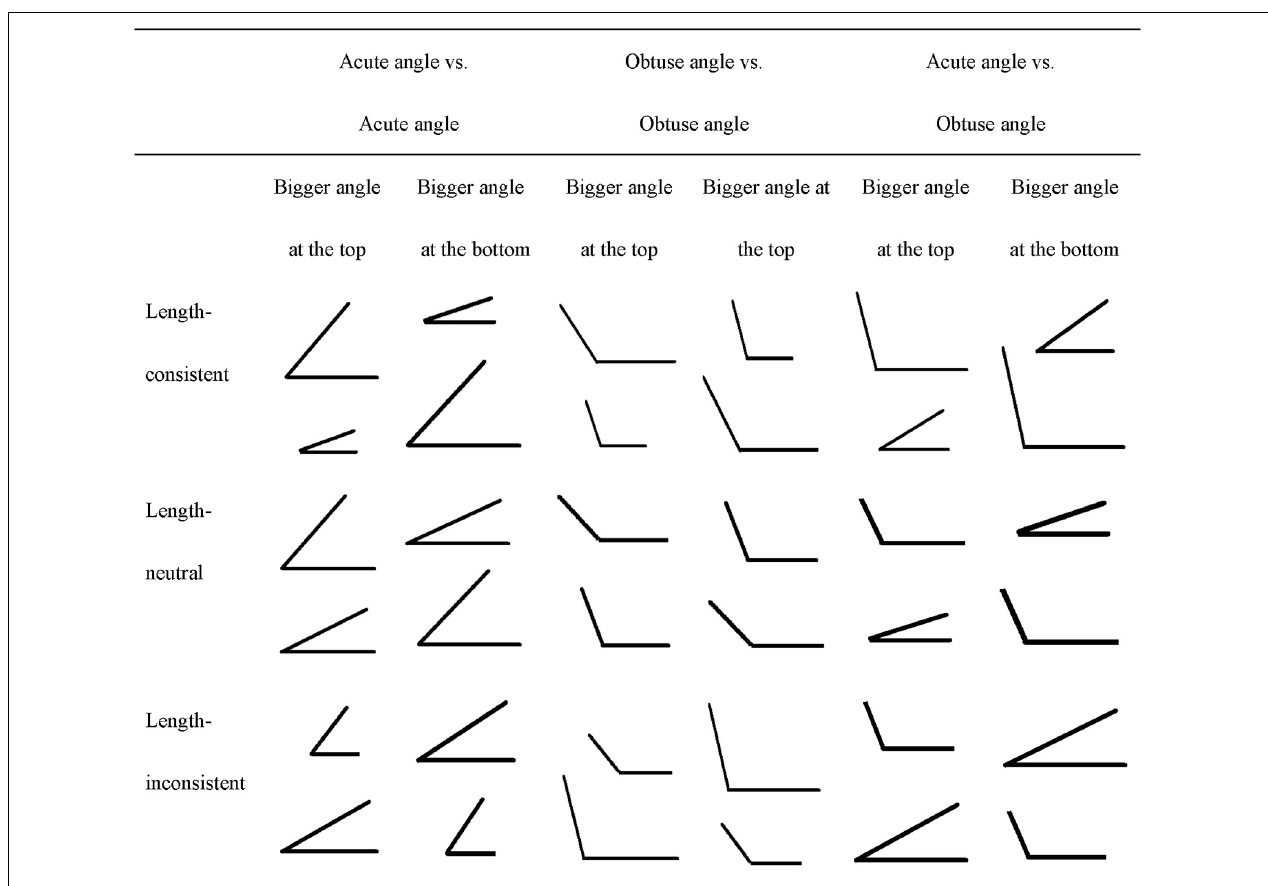
FIGURE 1 | Angle comparison